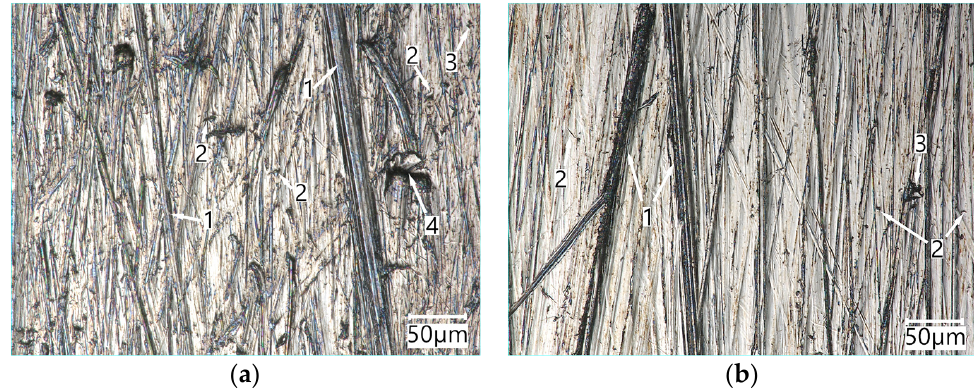
Figure 11. The surface of Hardox 600 steel worn in the medium soil ( a ) and light soil ( b ): 1— ploughing, 2 —micro-cutting, 3 —chippings, 4 —plastic deformation. Optical light microscopy. The view of the surface of Hardox 600 steel worn in the medium soil (Figure 11a) shows considerable damage to the surface due to ploughing, micro-cutting and plastic deformation of the material. The surface of Hardox 600 steel worn in the light soil (Figure 11b) also shows traces of ploughing and micro-cutting, with the grooves and micro-cutting traces being shallower than those for the medium soil. This can be attributed to the greater freedom of abrasive grains, which are less consolidated with the silty fractions in a light abrasive soil mass than in a medium abrasive mass. As regards the homogeneous material (without carbide precipitates in the microstructure), i.e., Hardox 600 steel, the weight loss is primarily caused by the sand fraction abrasive grains. The surface of the PMFe60P padding weld specimens after testing is presented in Figure 12. As regards the PMFe60P hardfaced layer, the presence of carbide precipitates in the microstructure resulted in less wear (Figure 12a).